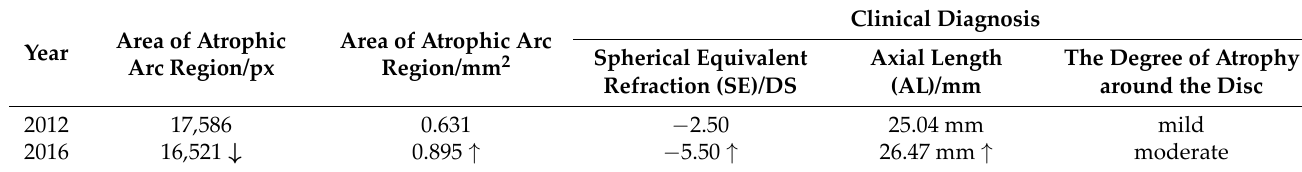
Table 6. Results of follow‑up examination of a myopic patient in 2012 and